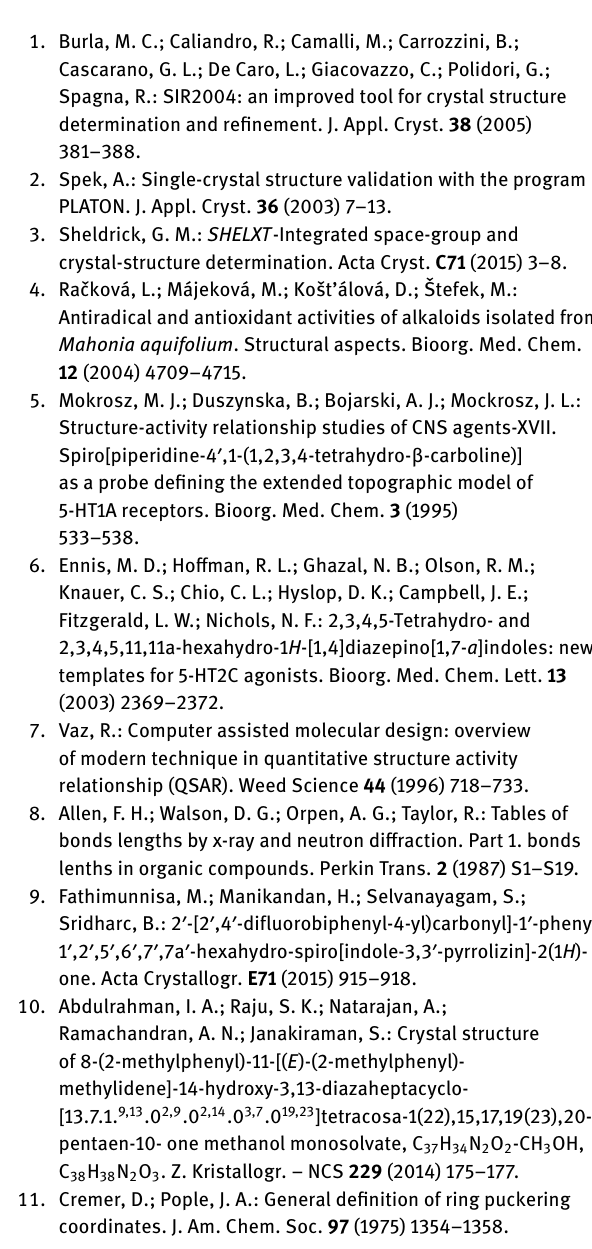
as a precursor. The crystal structure of the title compound should establish its